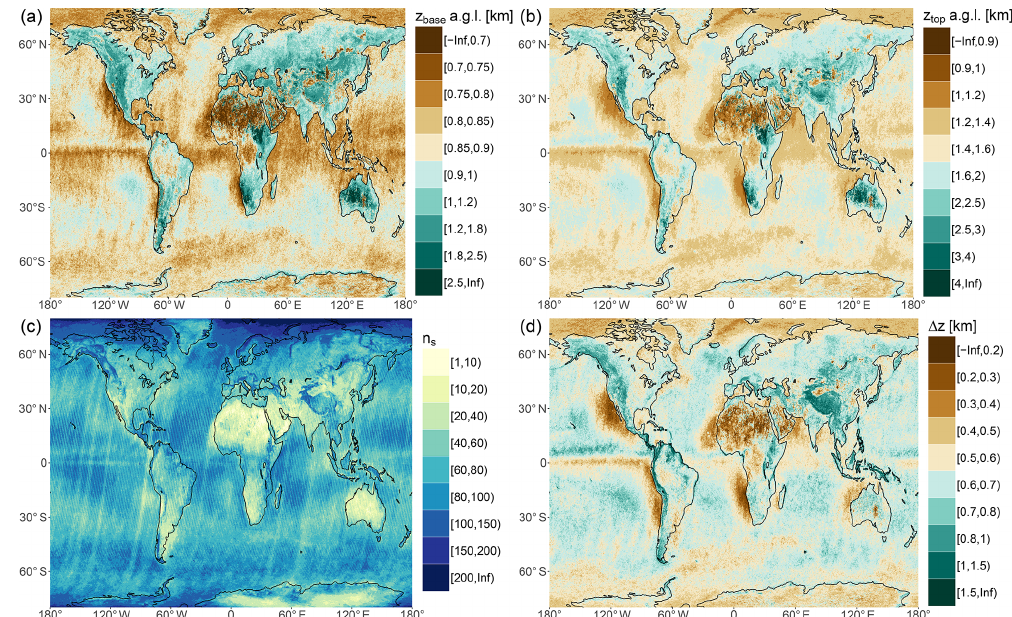
Figure 9. Global distribution of median cloud heights for a 3-year period (2007–2009). Shown are z base (a) , z top (b) and cloud vertical extent (d) on a 0.25 ◦ × 0.25 ◦ latitude–longitude grid. z base and z top are above ground level (a.g.l.). z base and z top retrievals are only included in the statistic if z base is below 5000m. The number of retrievals n s (c) represents the number of valid z base retrievals within this 3-year